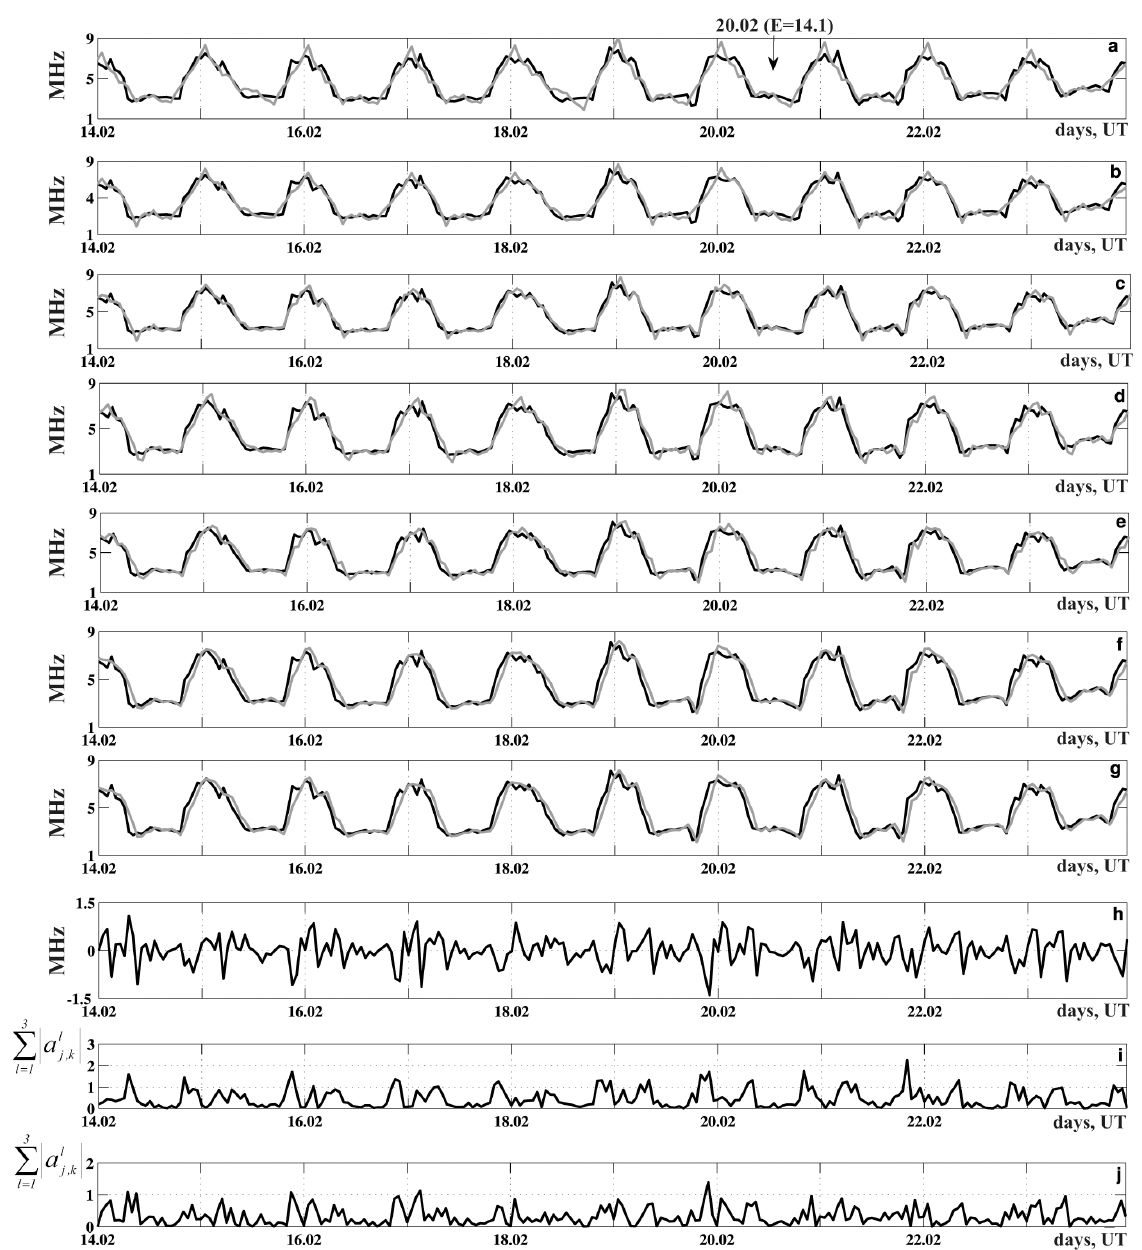
Figure 3. Simulation and prediction results for foF2 data. Black: original data foF2; grey: prediction. (a) Prediction for f 01 ( t ) with time advance q =1; (b) prediction of the sum f 01 ( t ) and g 3 (d,e,f,g) prediction of the sum f 01 ( t ), g 3 solute prediction error with time advance q =1; (j) absolute prediction error with time advance q =5. The arrow indicates a seismic event in Kamchatka (energy class k